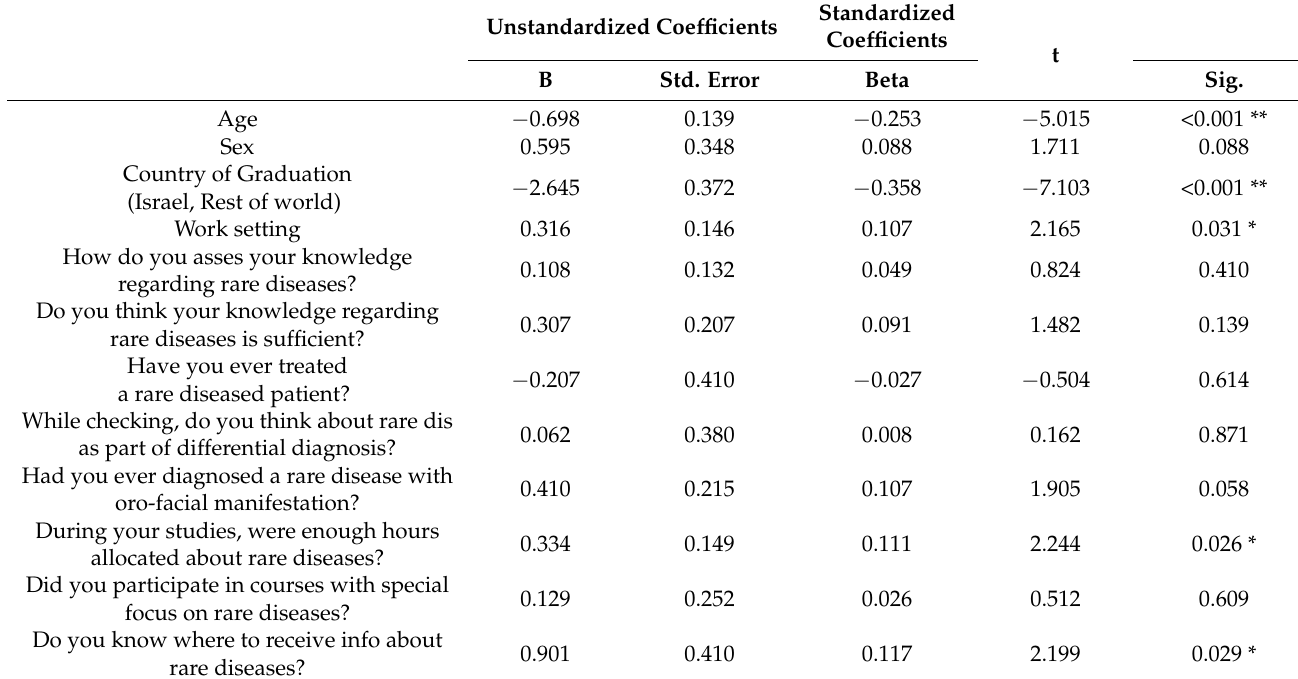
Table 4. Linear regression analysis utilizing the outcome variable “ Total rare diseases index ” as the dependent